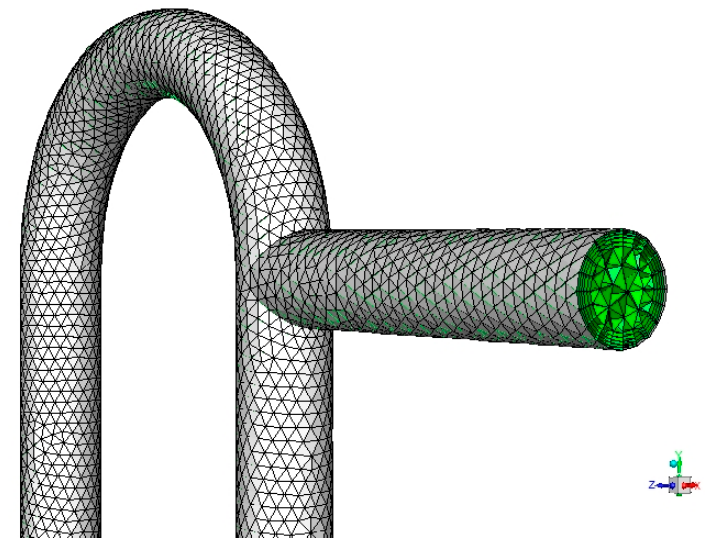
Figure 3. The computational mesh of the inverted U-tube.